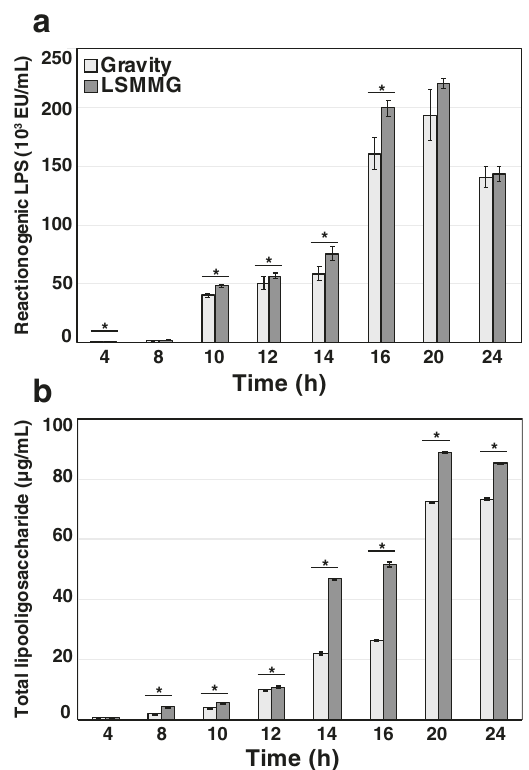
Fig. 2 Lipopolysaccharide (LPS) shedding by Vibrio fi scheri wild- type ES114 under low-shear modeled microgravity (LSMMG) and gravity conditions. a Reactogenic LPS as measured by the limulus amebocyte lysate endotoxin assay under gravity (light gray) and LSMMG (dark gray) conditions. b Total LPS levels as measured by the Purpald assay between LSMMG and gravity (G) conditions. Error bars indicate the standard error of the mean. Asterisks indicate signi fi cant differences between the data sets ( p < 0.05; Mann – Whitney U